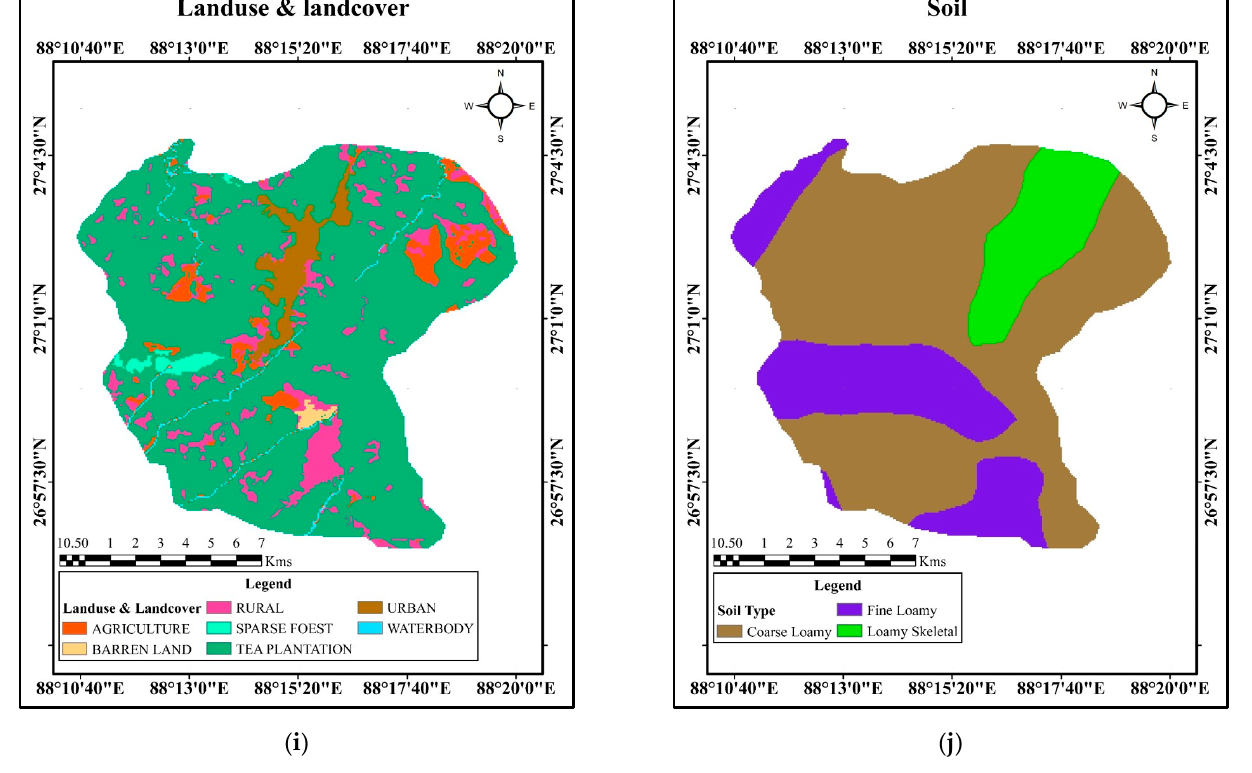
Figure 4. Landslide conditioning factor: ( a ) slope, ( b ) rainfall, ( c ) earthquake, ( d ) lineament density, ( e ) drainage density, ( f ) geology, ( g ) geomorphology, ( h ) aspect, ( i ) LULC, ( j ) soil.